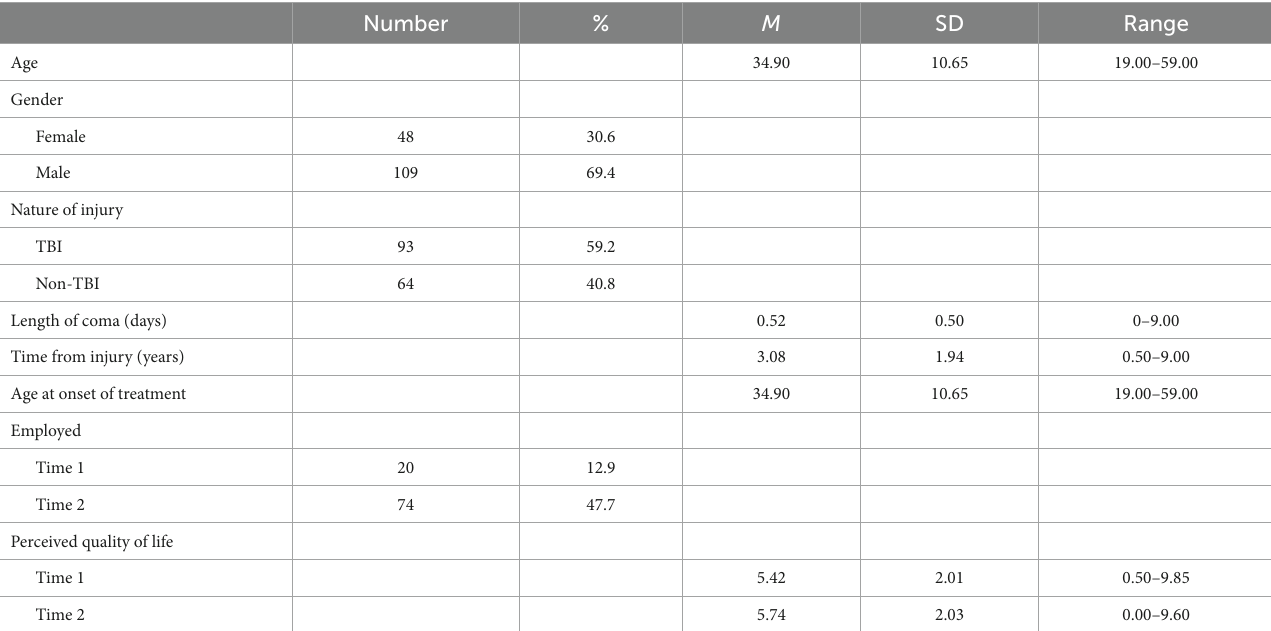
TABLE 1 Descriptive statistics for the study